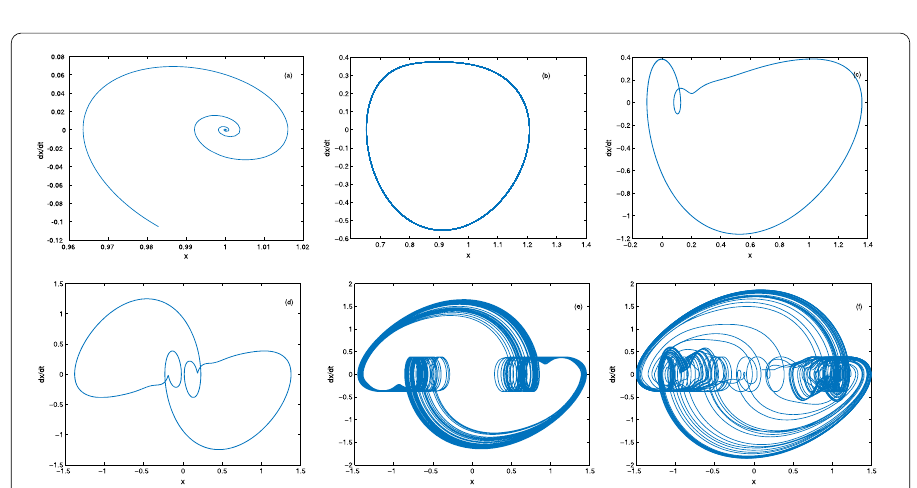
Figure 5 The phase plane plot in x – dx / dt space for different τ : ( a ) τ = 0.5 (stability), ( b ) τ = 0.9 (period-1), ( c ) τ = 1.3 (period-2), ( d ) τ = 1.35 (period-4), ( e ) τ = 1.55 (chaos), ( f ) τ = 1.65 (chaos) with parameter γ =